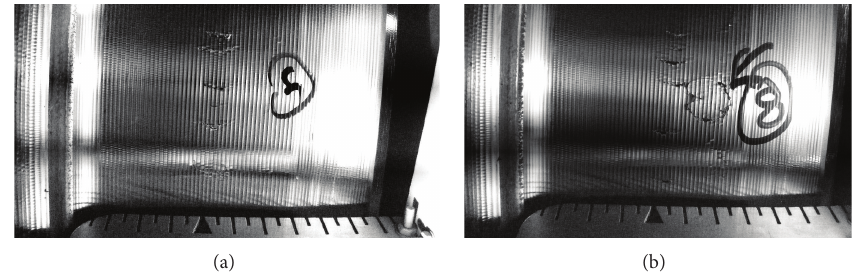
Figure 7: Subsurface cracks in centre of wheel tread, observed during turning of wheel on lathe: 2 images from different parts of the same wheel. Cracks were not visible on surface, although there was an unusual 0.4 mm out of roundness identified by the lathe in this region. Numerous curved transverse cracks appeared after 1.5 mm of material was removed from the surface; some appeared circular. Flange to left- hand side, tread datum 70 mm from flange back, is indicated by the arrow shape at the bottom of the image, with scale in 5mm increments.